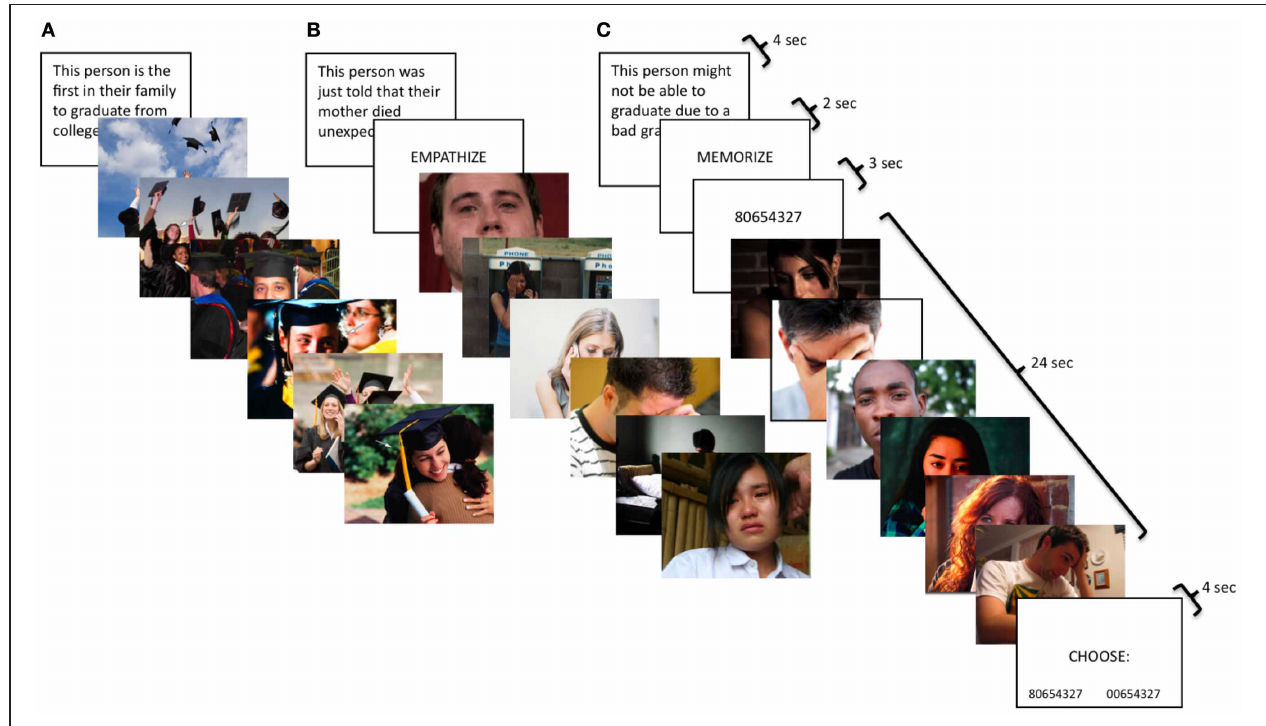
FIGURE 1 | Participants viewed naturalistic stimuli with three types of instructions: (A) watch, (B) empathize, and (C) memorize combined with three different emotions: (1) happiness, (2) sadness, and (3)